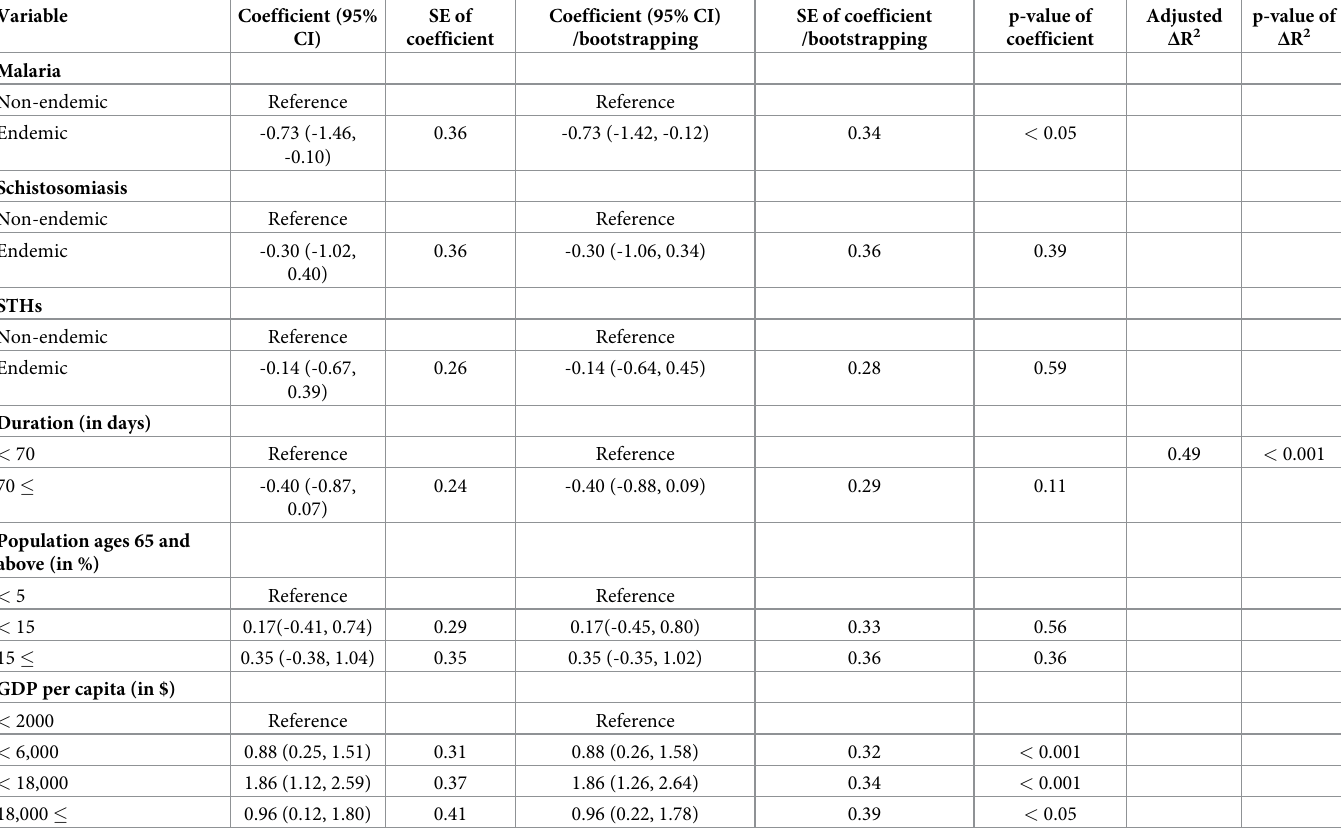
Table 5. Summary of multivariable linear regression, including parasite variables of interest and potential